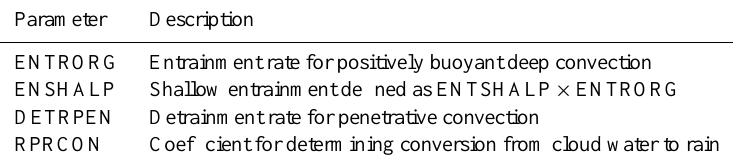
Table 1. The sub-set of IFS closure parameters with time-invariant parameter variations.